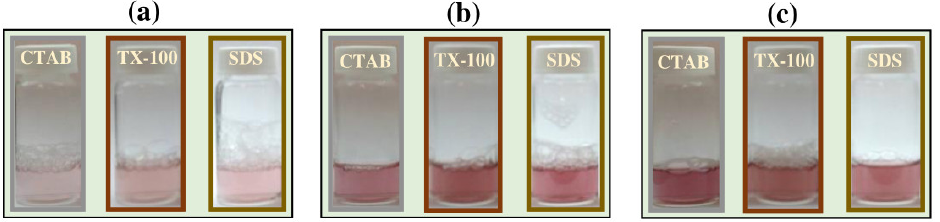
Figure 2. The solution color of the Au NPs using different surfactants at ( a ) 0.1 J cm −2 , ( b ) 0.2 J cm −2 , and ( c ) 0.4 J cm −2 . The ablation time was 20 min and the surfactant concentration was 10 mM.